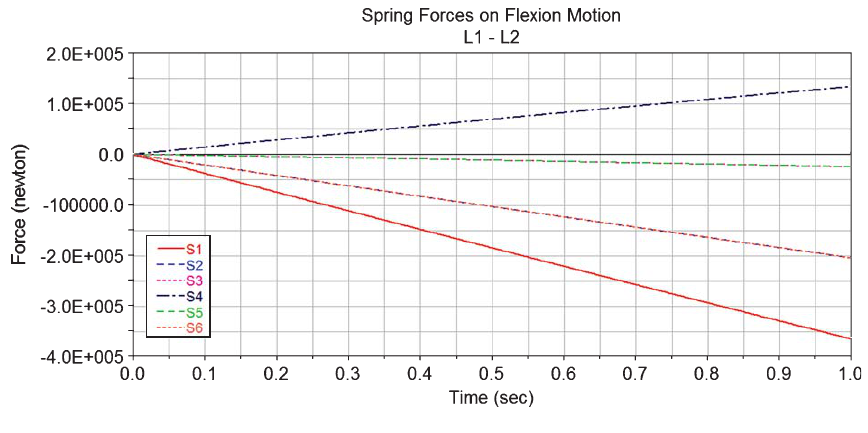
Fig. 11. Computed forces in S 1 , i springs for a simulated flexion of the lumbar spine segment.